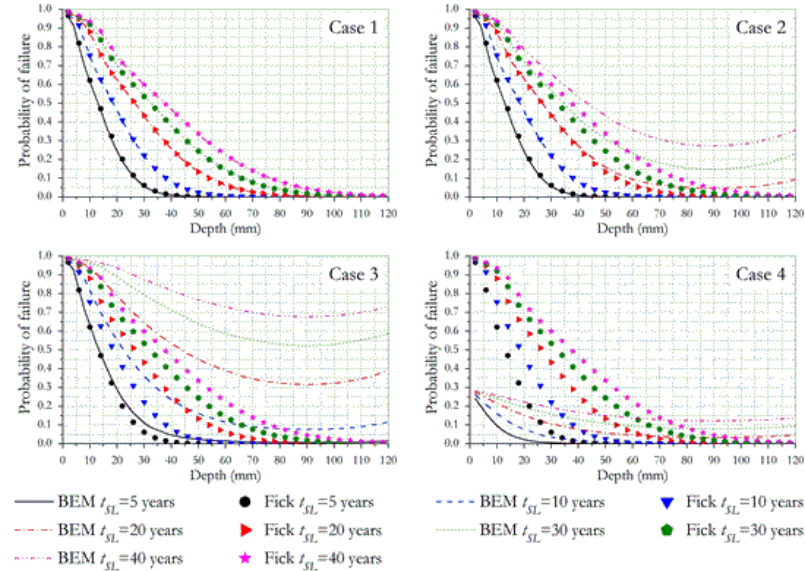
Figure 9 – Evolution of the probability of failure along time.